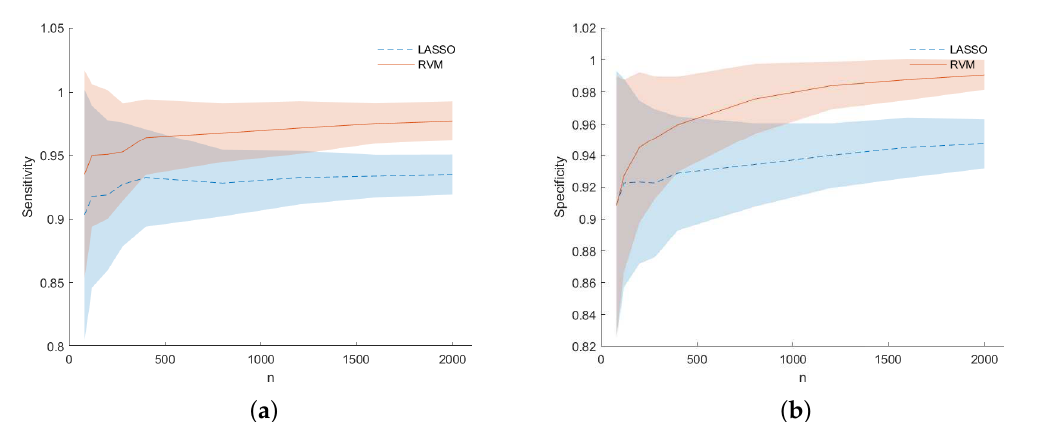
Figure 6. dataset (f): Sensitivity ( a ) and specificity ( b ) as regard Prediction Accuracy (PA) for LASSO (dashed) and RVM (soid). The shaded areas represent the standard deviation obtained across the MC simulation.